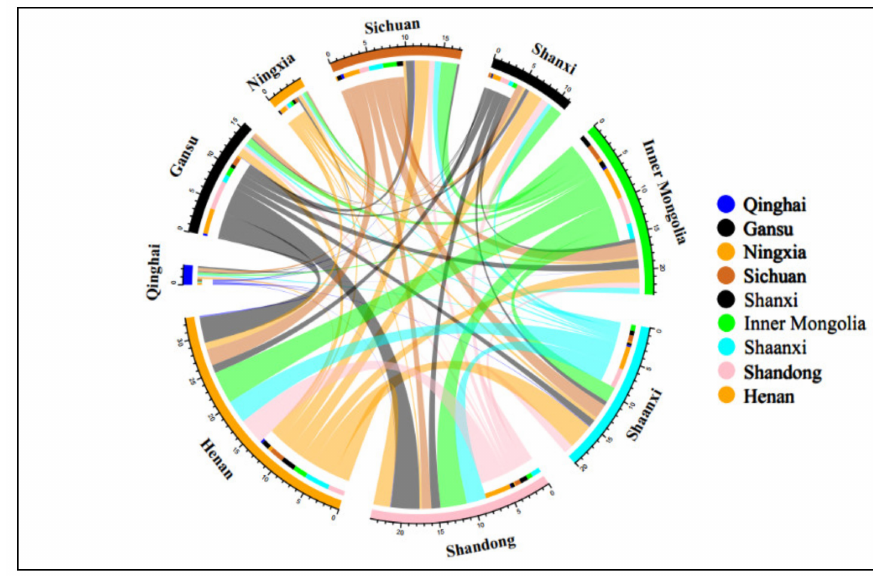
Figure 11. Virtual water flow in the Yellow River Basin (100 million m 3